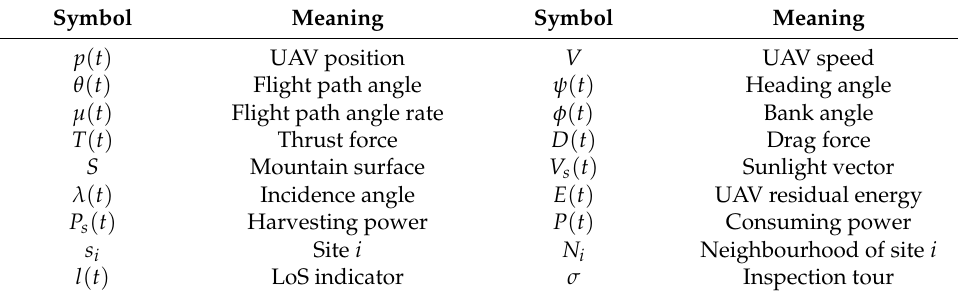
Table 1. Frequently used symbols and their